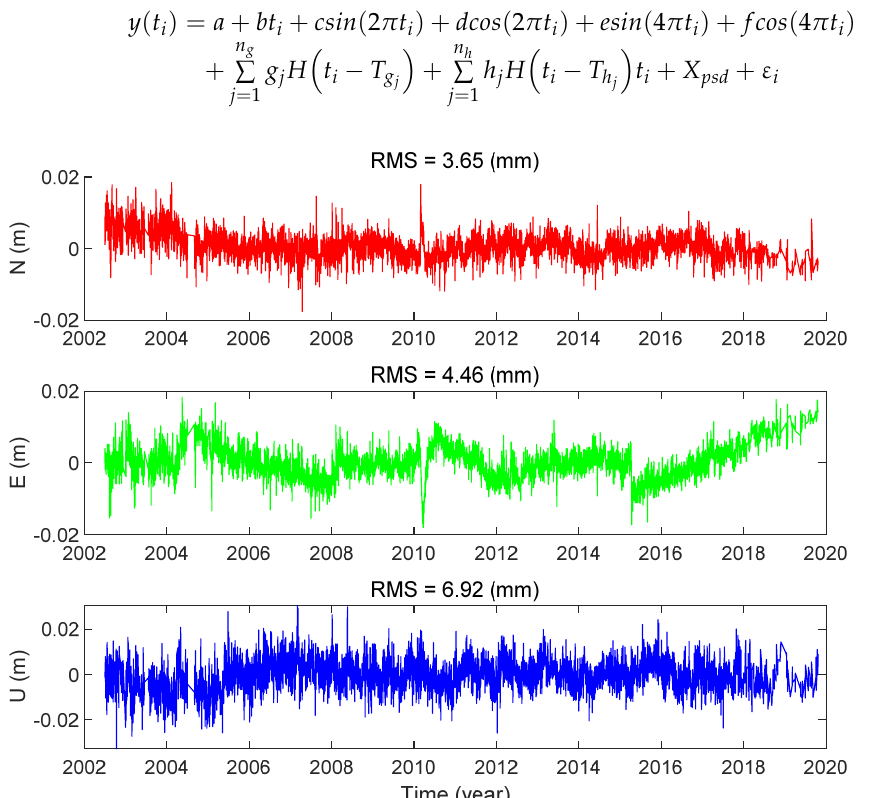
Figure 19. Fitting Residuals of ANTC based on the ITSM.